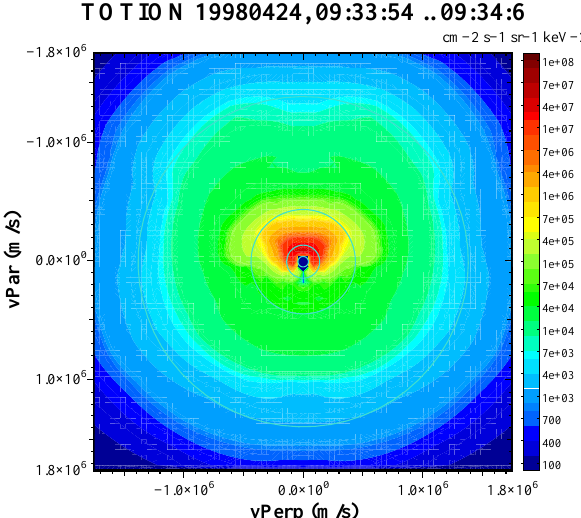
Fig. 3. Total ion distribution function from TIMAS at 09:32 during the event shown in Fig. 2. A clear shell distribution is seen starting from 0 . 8 × 10 6 m/s (3.5 keV). The blue circles correspond to en- ergies 10 eV (0 . 044 × 10 6 m/s), 100 eV (0 . 14 × 10 6 m/s), 1 keV (0 . 44 × 10 6 m/s) and 10 keV (1 . 4 × 10 6 m/s).